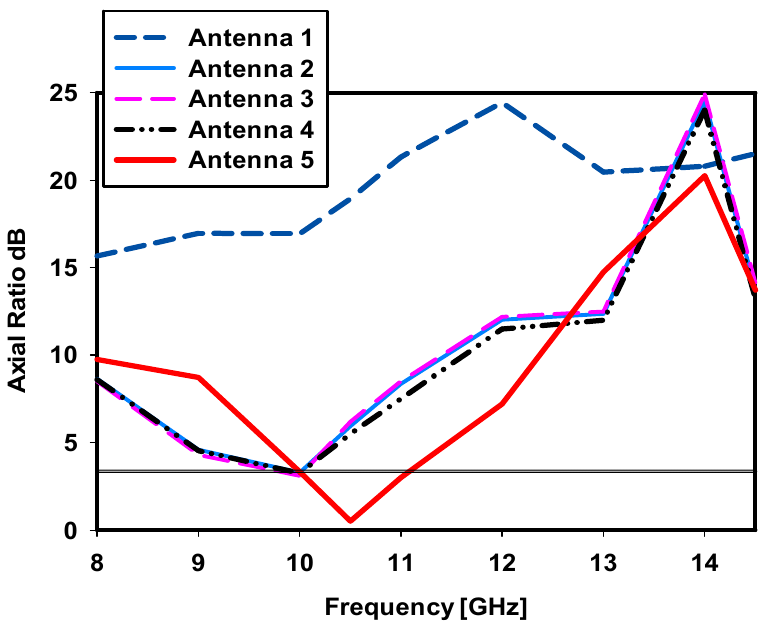
Figure 4. Axial ratios of the proposed design for the different design steps.